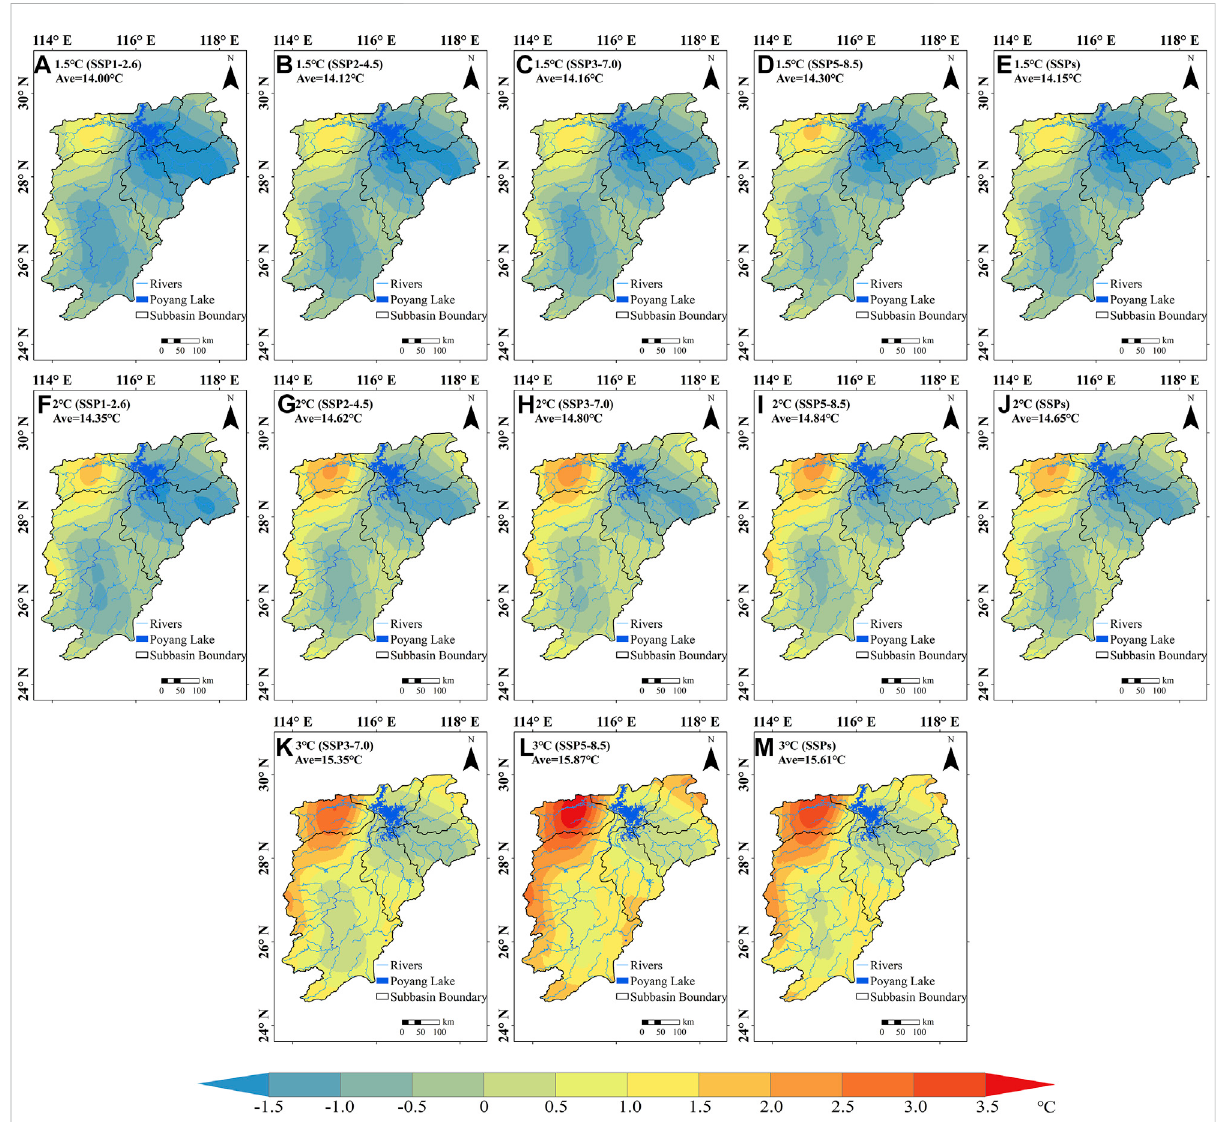
FIGURE 12 Spatial distribution of Tasmin in the PLB relative to the reference period (1986 – 2005). (A – E) are the 1.5 ° C global warming target. (F – J) are the 2 ° C global warming target. (K – M) are the 3 ° C global warming target. (E,J,M) are the emission scenarios averaging results.